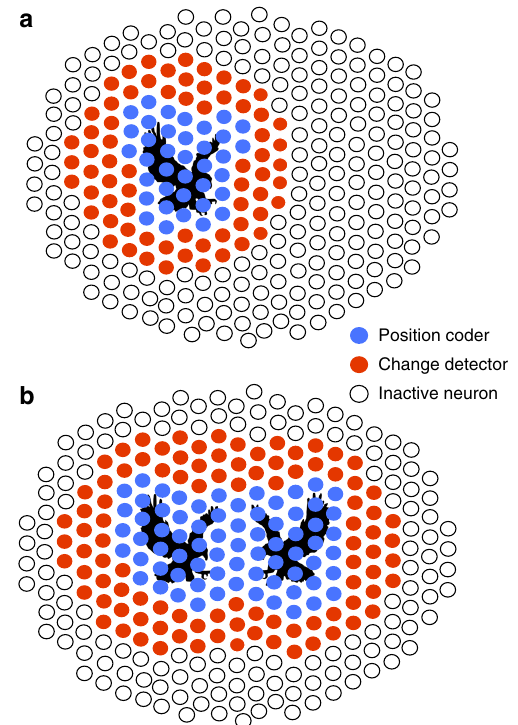
Fig. 8 Cells of a single-type switch between two different computations. a Schematic of how cells of the fast OFF type code for a moving stimulus (here an eagle depicted in black). Each circle represents a fast OFF cell. Empty circles correspond to inactive cells, red circles to cells acting as change detectors, while blue cells are sensitive to the exact position of the stimulus. b Reorganization in the population code following the simultaneous display of two stimuli. Same legend as